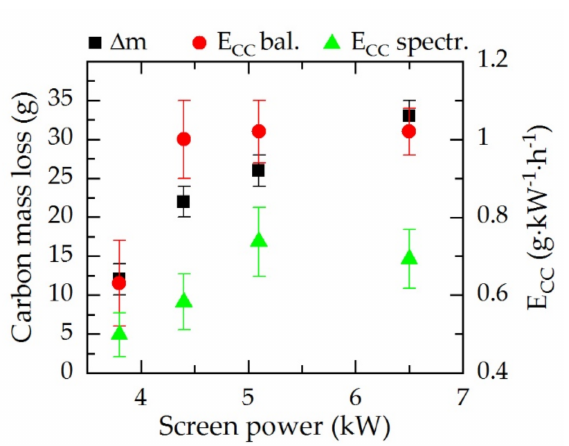
Figure 2. Carbon mass loss ( ∆ m , black) and carbon consumption ( E CC ) determined after the process by the balance ( E CC bal., red) and by spectroscopic data ( E CC spectr., green) of the screen material in dependence of the resulting screen power for a gas composition of N 2 :H 2 = 1:1, 5 h treatment